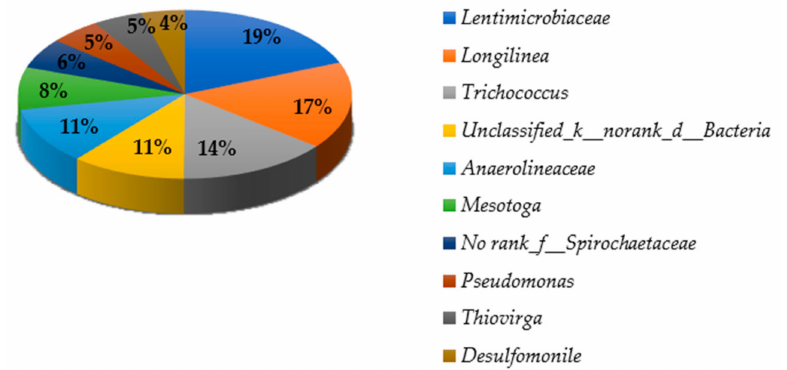
Figure 2. The bacterial diversity of cake layer in genus